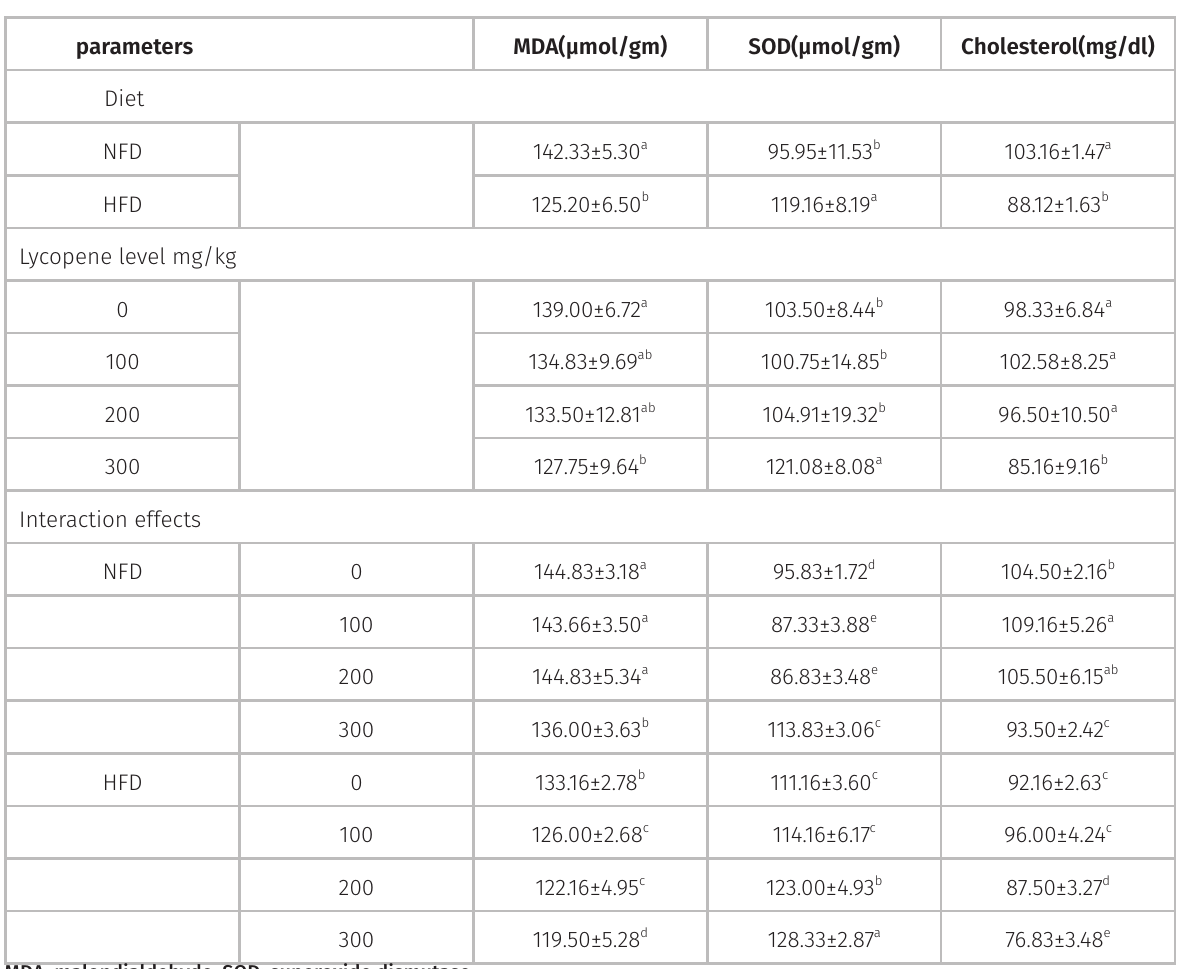
Table V. Effects of graded levels of lycopene supplementation to normal fat diet (NFD) and high-fat diet (HFD) on antioxidant enzymes and cholesterol level in the chest muscle of Japanese